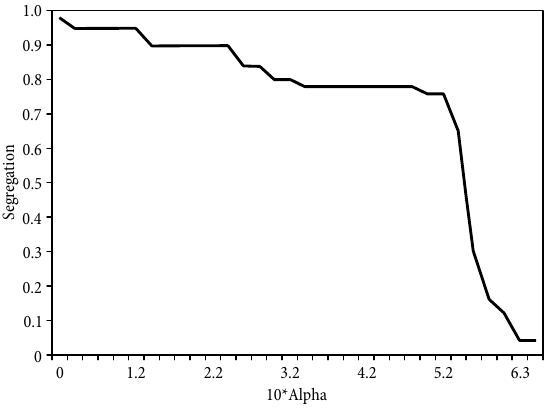
Fig. 7. Segregation equilibria with n